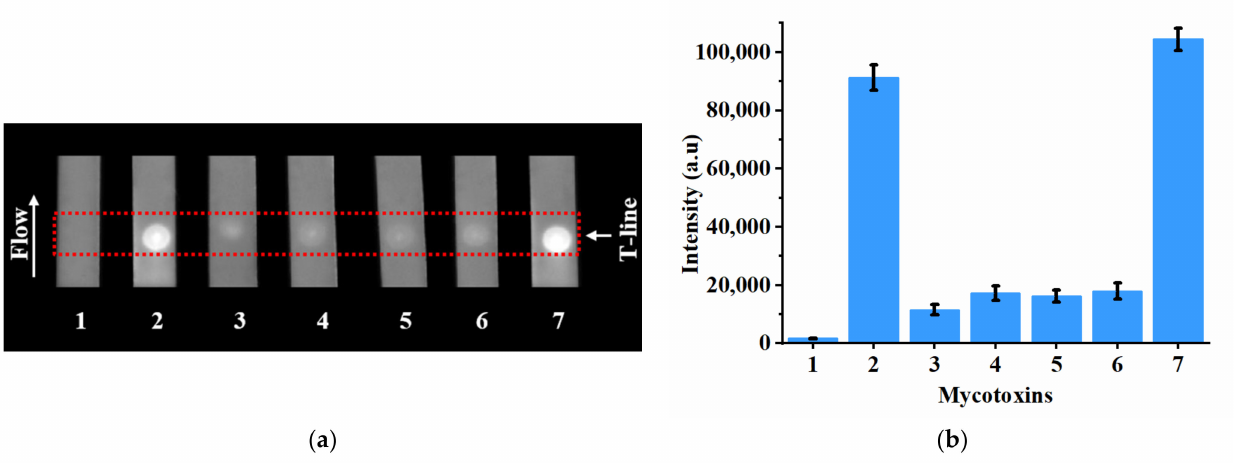
Figure 3. Specificity verification of the Apt-strip by comparing AFB 1 (50 ng/mL) and four other mycotoxins (50 ng/mL). ( a ) Images of the results of the Apt-strip assaying various toxins. ( b ) Com- parison of intensity of various toxins detected using Apt-strip. From left to right: ( 1 ) blank; ( 2 ) AFB 1 ; ( 3 ) OTA; ( 4 ) AFG 1 ; ( 5 ) AFG 2 ; ( 6 ) ZEN; ( 7 ) mixture of AFB 1 and other four